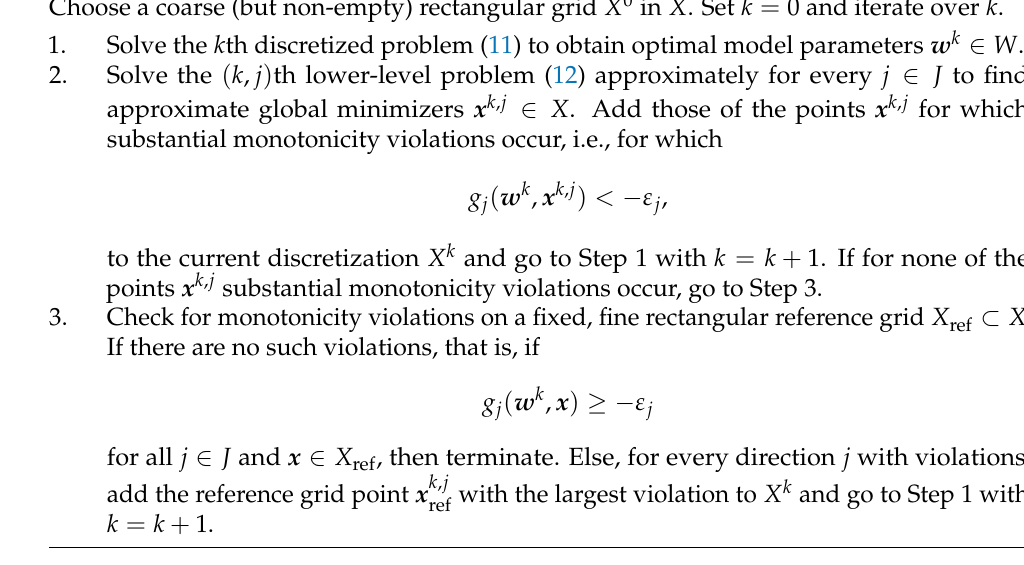
Algorithm 1 Adaptive discretization algorithm for monotonic